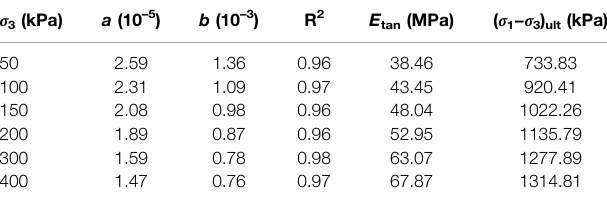
TABLE 4 | Results of the Konder model for the studied clay before FT cycles.